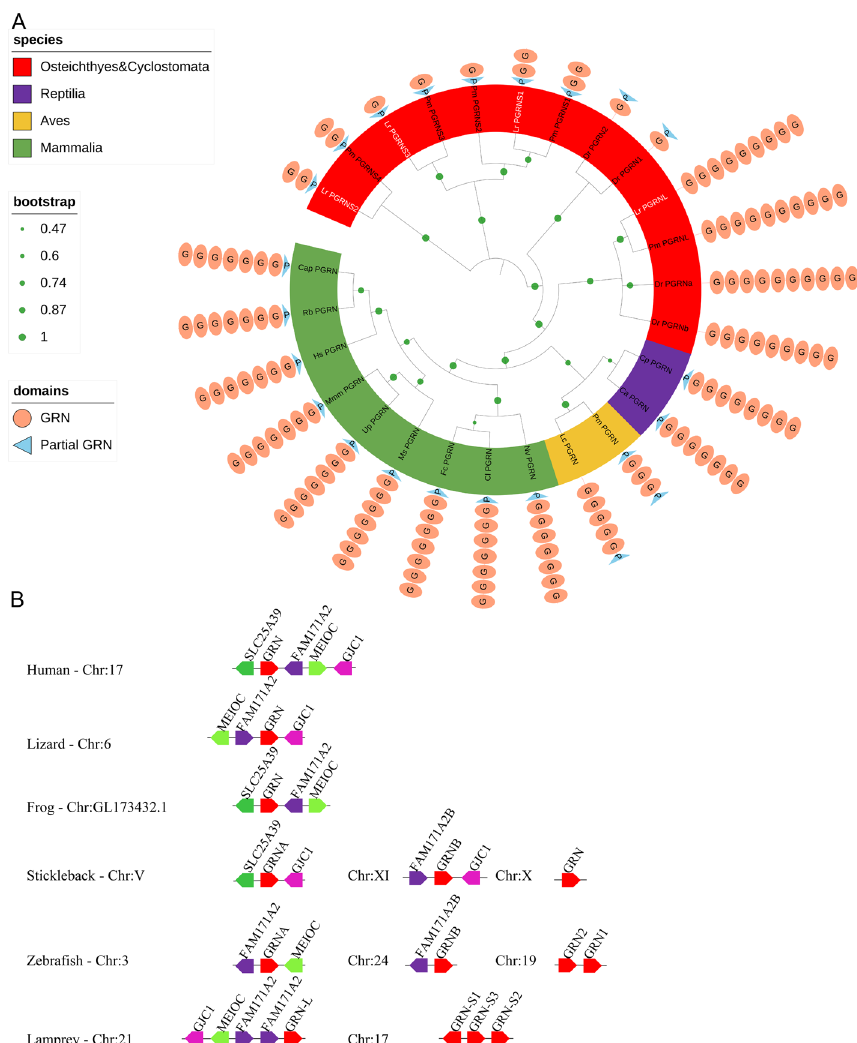
Fig. 1 Phylogenetic tree and synteny analysis of the PGRN family. A Topological analysis of the resulting NJ tree with PGRNs of jawless and jawed vertebrates, including Mammalia (green background), Aves (yellow background), Reptilia (purple background), Osteichthyes, and Cyclostomata (red background). Light-salmon ellipse with G: domains of PGRN; light blue triangle with P: partial PGRN domain. The green circle on the branch points of the phylogenetic tree represents bootstrap values; the larger the circle area, the higher the bootstrap value. B Collinear analysis of pgrn genes in jawless and jawed vertebrates. The pentagon represents a gene, and identical genes are represented by the same color. The black line represents chromosome (Chr). The right side of the lamprey pgrn-l was considered to be the positive